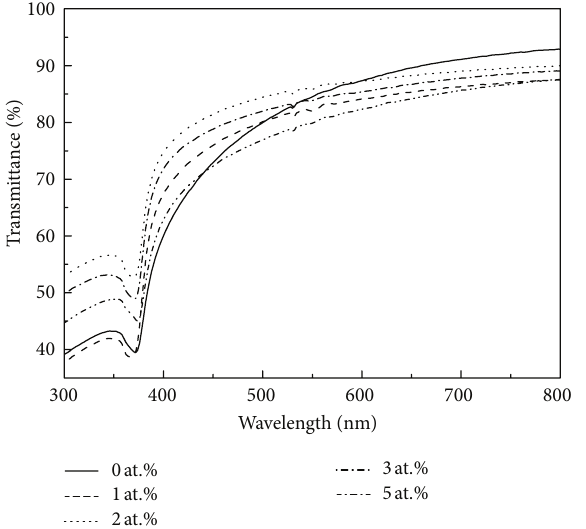
Figure 4: The plots of (𝛼ℎ V ) 2 versus ℎ V of ZnO:In films with different dopant concentrations (0–5